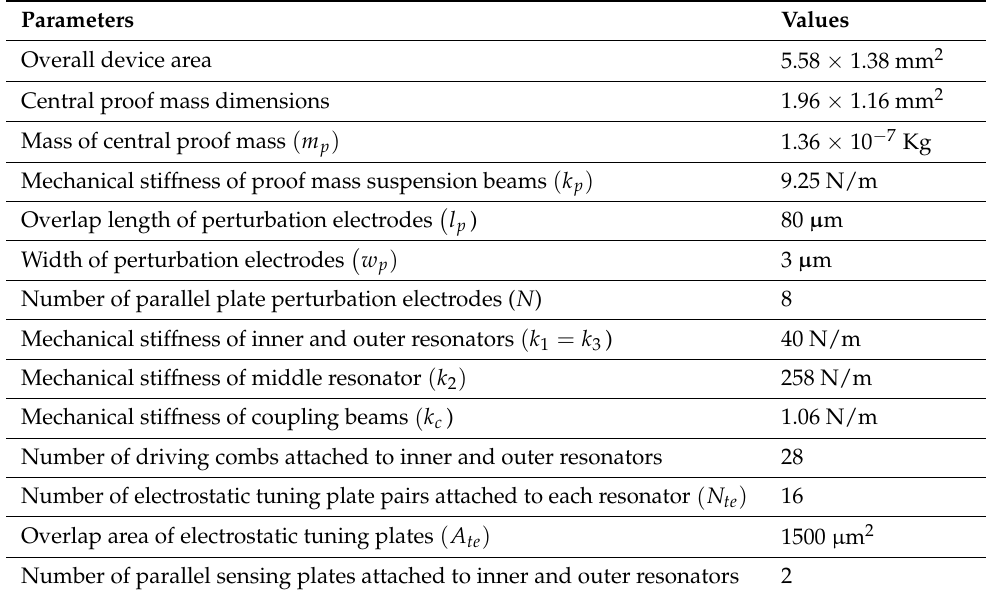
Table 1. Dimensions of the proposed MEMS accelerometer